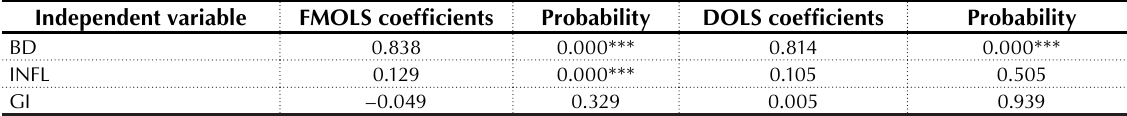
Table 4. FM OLS and DOLS results Dependent variable: GDP